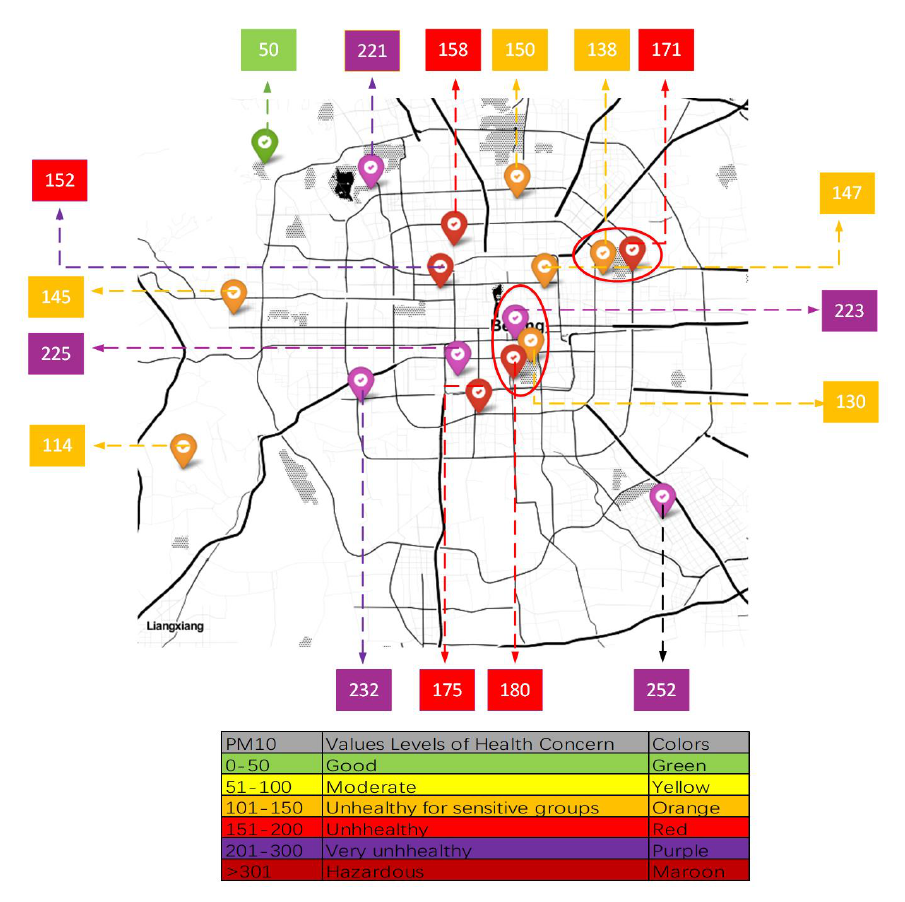
Figure 1. Beijing air-quality distribution on a certain day. The monitoring stations in the red circle are very geographically close, but the PM 10 concentration varies greatly throughout the